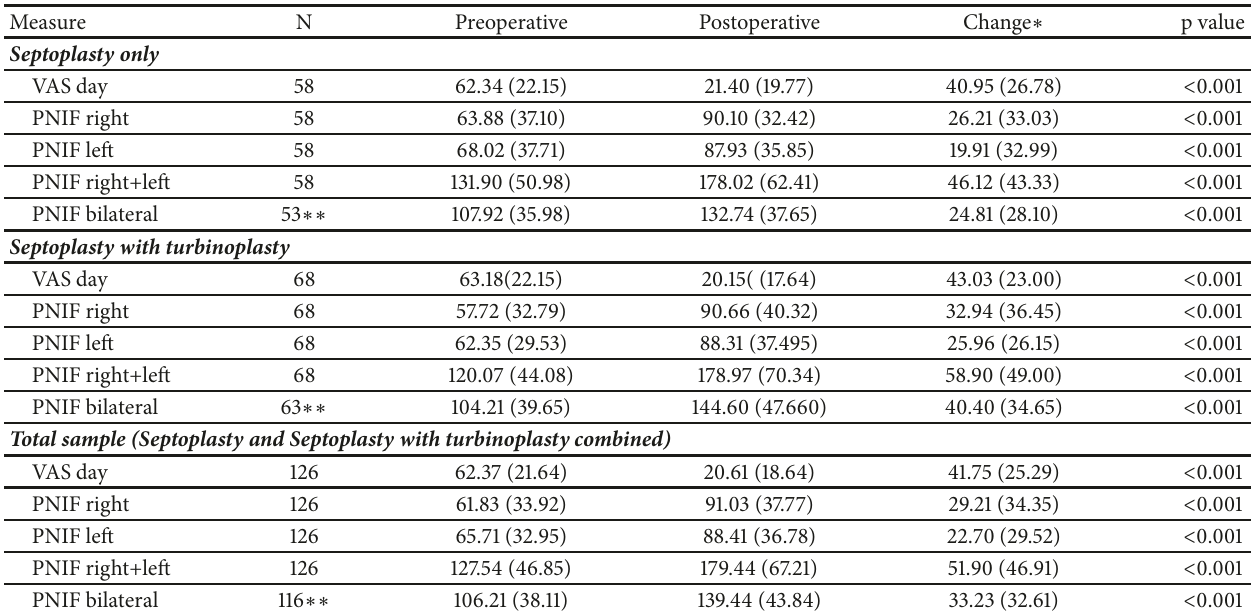
Table 1: PNIF and VAS preoperative, postoperative, and change scores for septoplasty, septoplasty with turbinoplasty, and the total sample.